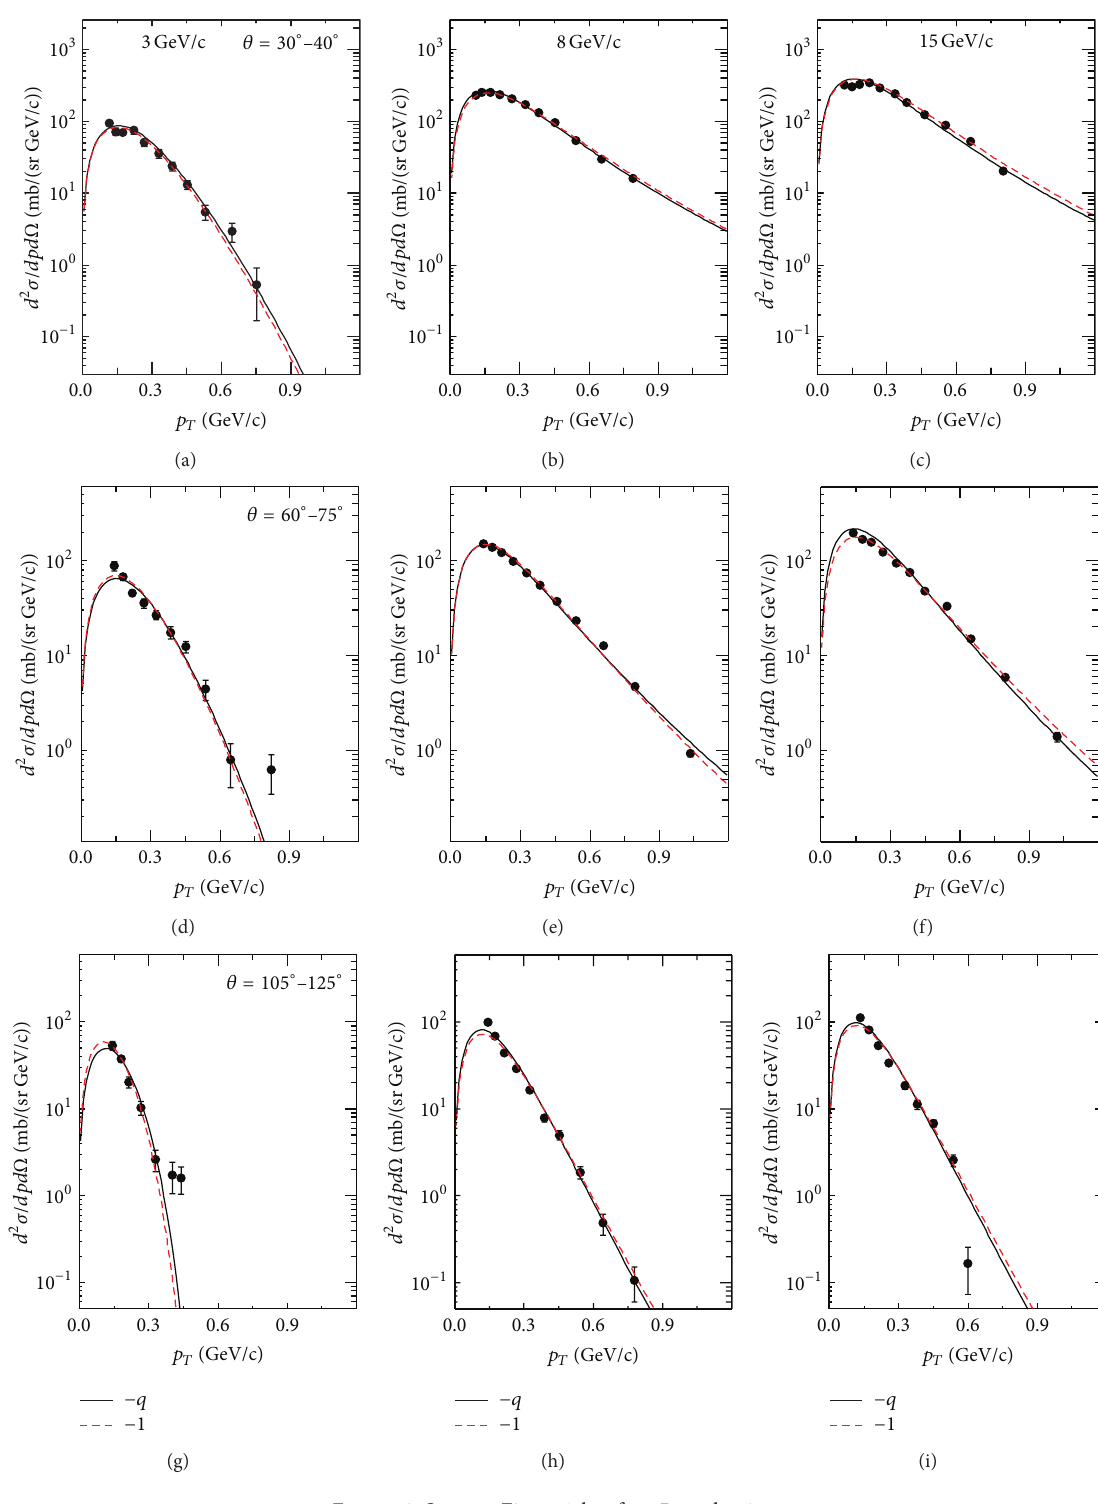
Figure 2: Same as Figure 1, but for 𝜋 −